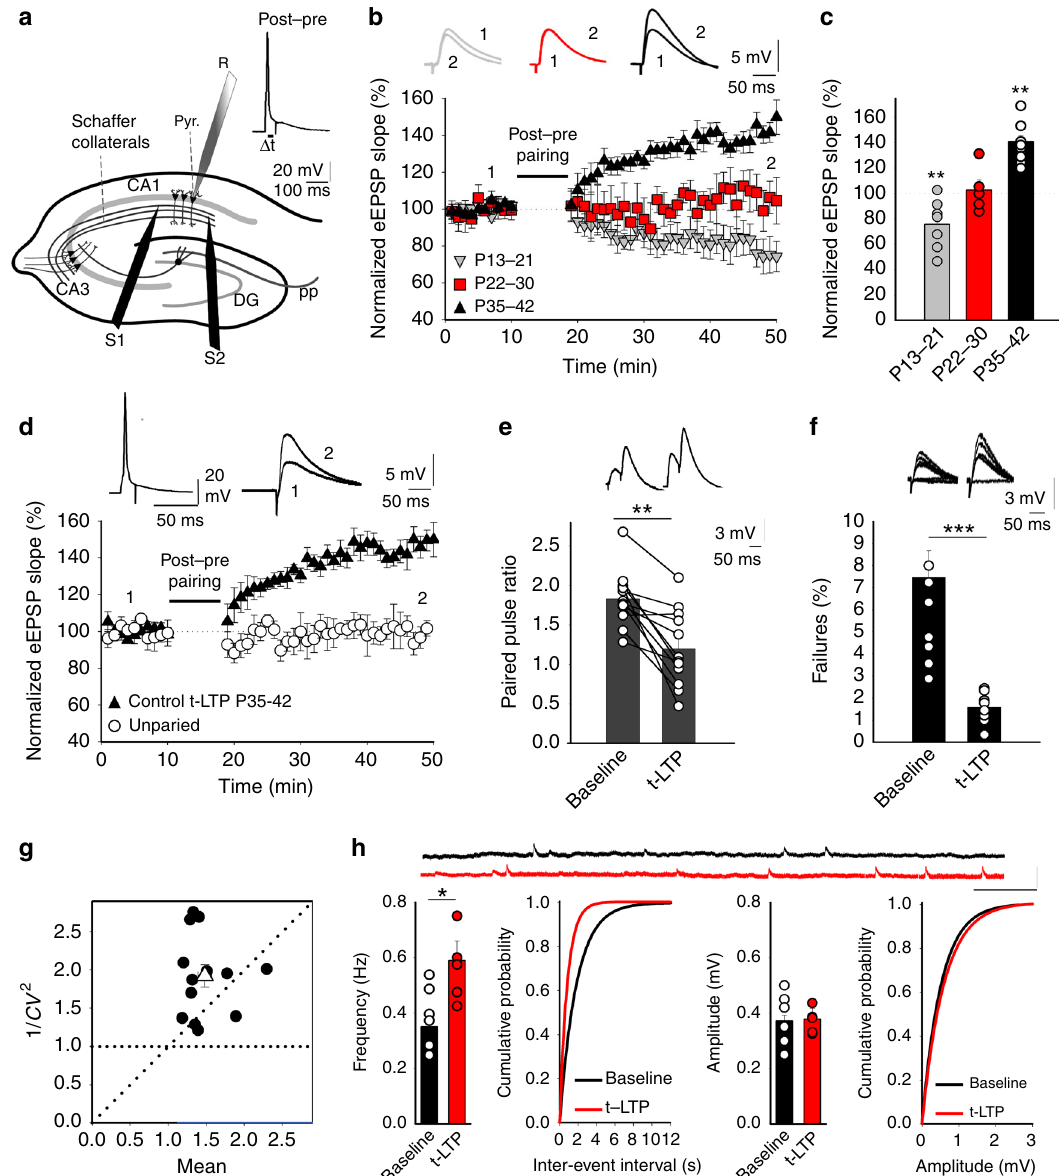
Fig. 1 Presynaptic t-LTD at P13 – 21 in the hippocampus switches to t-LTP at P35 – 42. a Left, scheme showing the general experimental set-up: R, recording electrode; S1 and S2, stimulating electrodes; right, pairing protocol utilized ( Δ t, time between the peak of the spike and EPSP onset). b A post-pre single-spike pairing protocol induces t-LTD at P13 – 21 (gray triangles, n = 7). This t-LTD is evident during the third week of development but it disappears during the fourth week (red squares, n = 6) and switches to t-LTP during the fi fth week (black triangles, n = 13). The EPSP slopes monitored are shown. Traces show the EPSP before (1) and 30 min after (2) pairing. c Summary of the results. ** p < 0.01, two-sided Student ’ s t test. d A post-pre protocol induces t-LTP at P35 – 42. The EPSP slopes monitored in paired (black triangles, n = 13) and unpaired pathways (white circles, n = 13) are shown. The traces show the EPSP before (1) and 30 min after (2) applying the induction protocol in the paired pathway, only the paired pathway showed t-LTP. e – h t-LTP induced by a post-pre protocol at P35 – 42 is expressed presynaptically. PPR decreases after t-LTP: sample traces at baseline and 30 min after induction of t- LTP, n = 13, ** p < 0.01, two-sided Student ’ s t test. For detailed PPR values see Supplementary Data 1 e . The number of failures decreases after t-LTP induction f . Sample traces at baseline and 30 min after induction of t-LTP ( n = 10, *** p < 0.001, two-sided Student ’ s t test). g Normalized plot of CV − 2 versus mean EPSP slope yields data points mainly above the diagonal after induction of t-LTP ( n = 13). h Miniature EPSP (mEPSPs) monitored during the baseline and after t-LTP induction in the presence of TTX (500 n M ). Histograms and cumulative graphs show that after t-LTP induction, the frequency of mEPSPs increases, whereas the amplitude of mEPSP remains constant ( n = 6). Scale bars: 1 mV, 1 s. * p < 0.05, two-sided Student ’ s t test. The error bars represent the S.E.M. Source data are provided as a Source Data fi